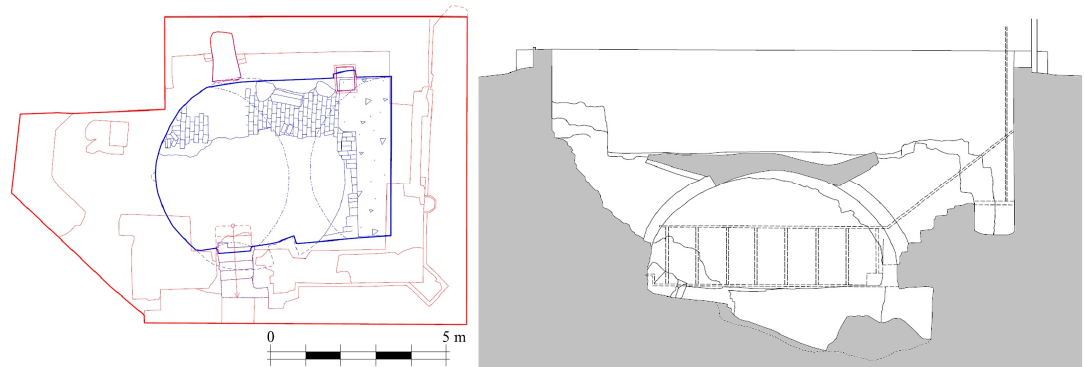
Figure 2. Floor plan of the chapel (red—upper floor, blue—ossuary in the basement) ( left ) and cross section ( right ).